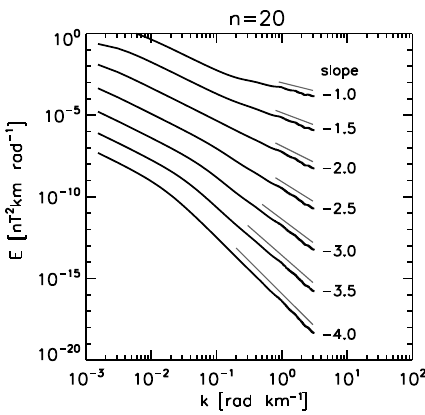
Figure 4. Minimum variance spectra for different slopes using 20 sampling points. Gray lines indicate the true spectral